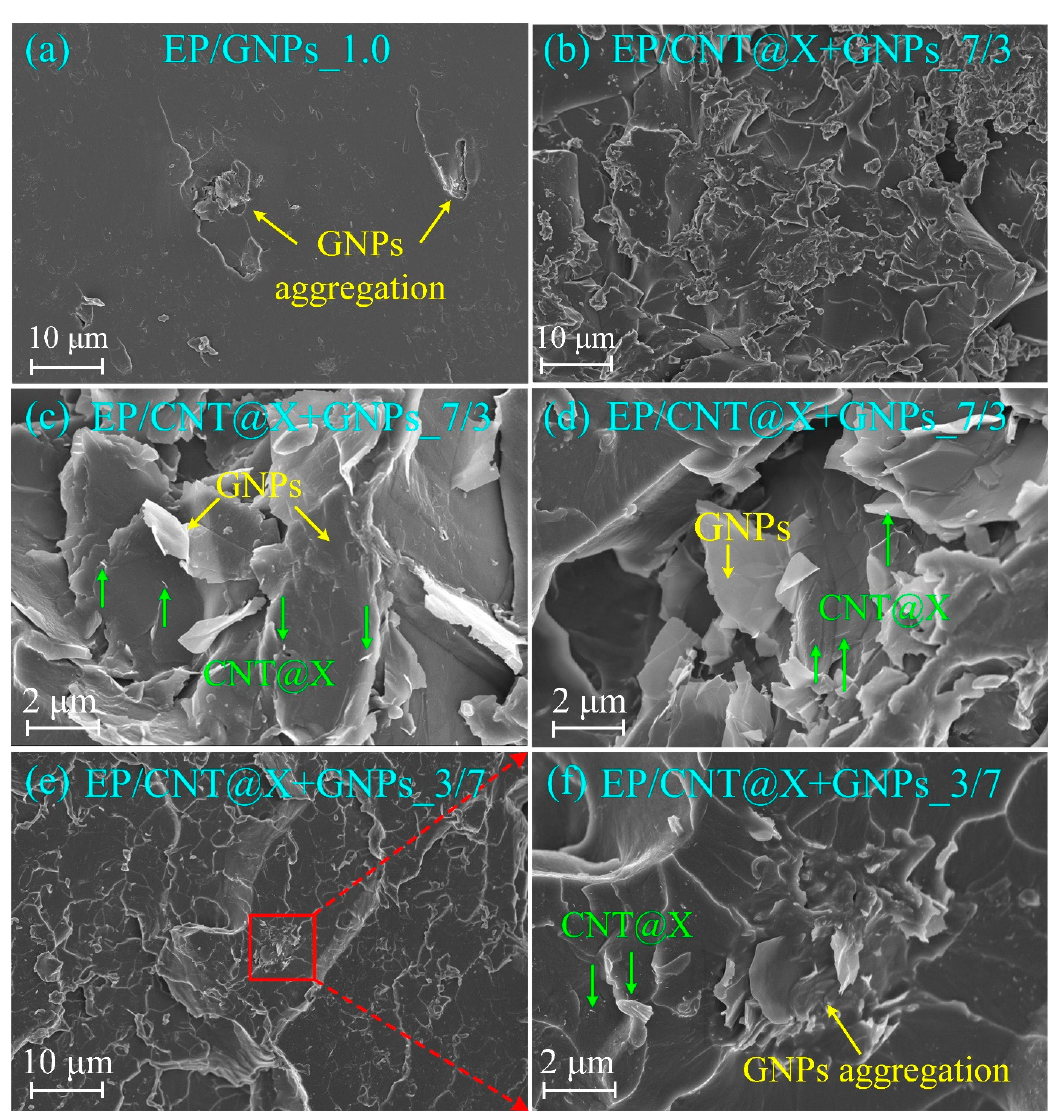
Figure 8. Fracture micrographs for different nanocomposite specimens under the quasi-static 3P-ENB loading condition.